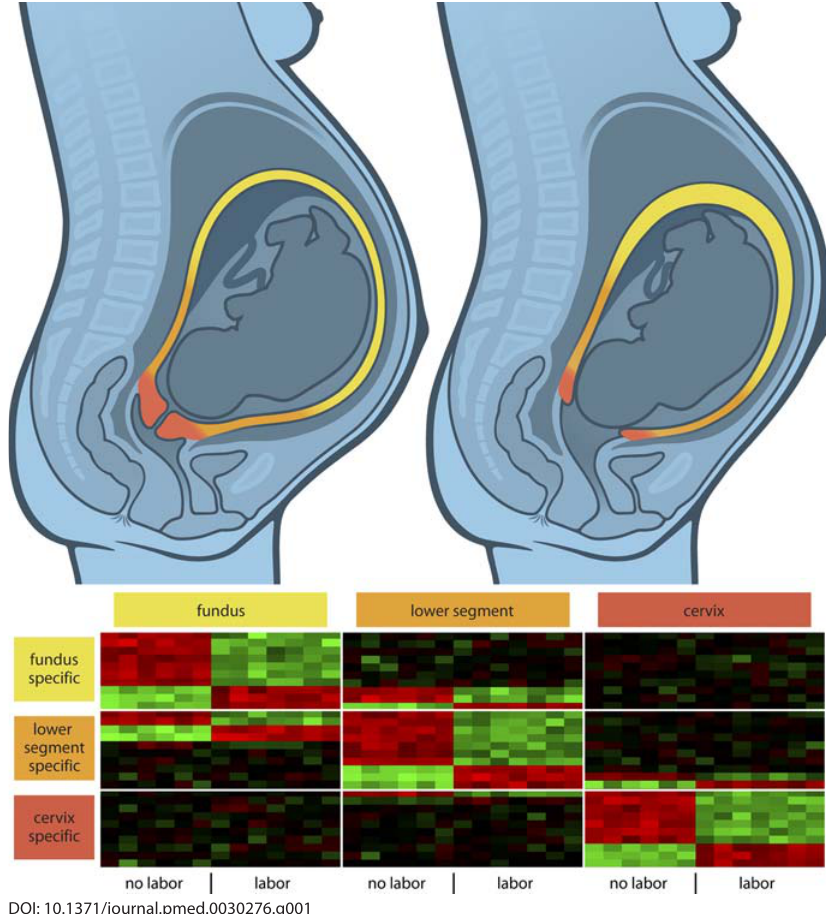
Figure 1. Study of the Transcriptome of the Uterine Fundus, Lower Uterine Segment, and Cervix in Women Not in Labor (Left) and in Labor